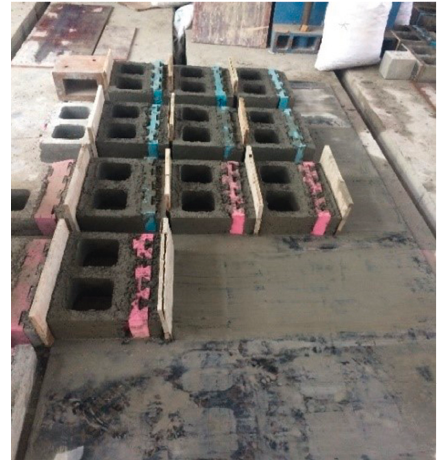
Figure 8: Blocks being cured.